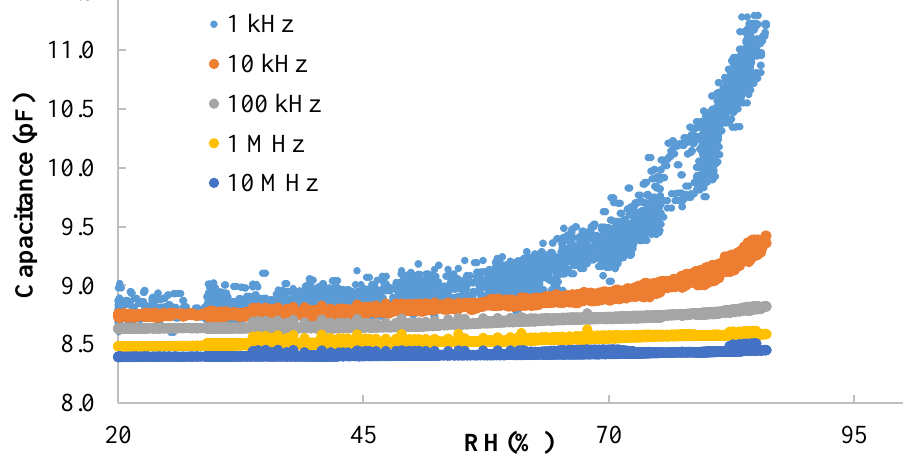
Figure 3. Capacitance vs. RH at different frequencies and 40 °C.